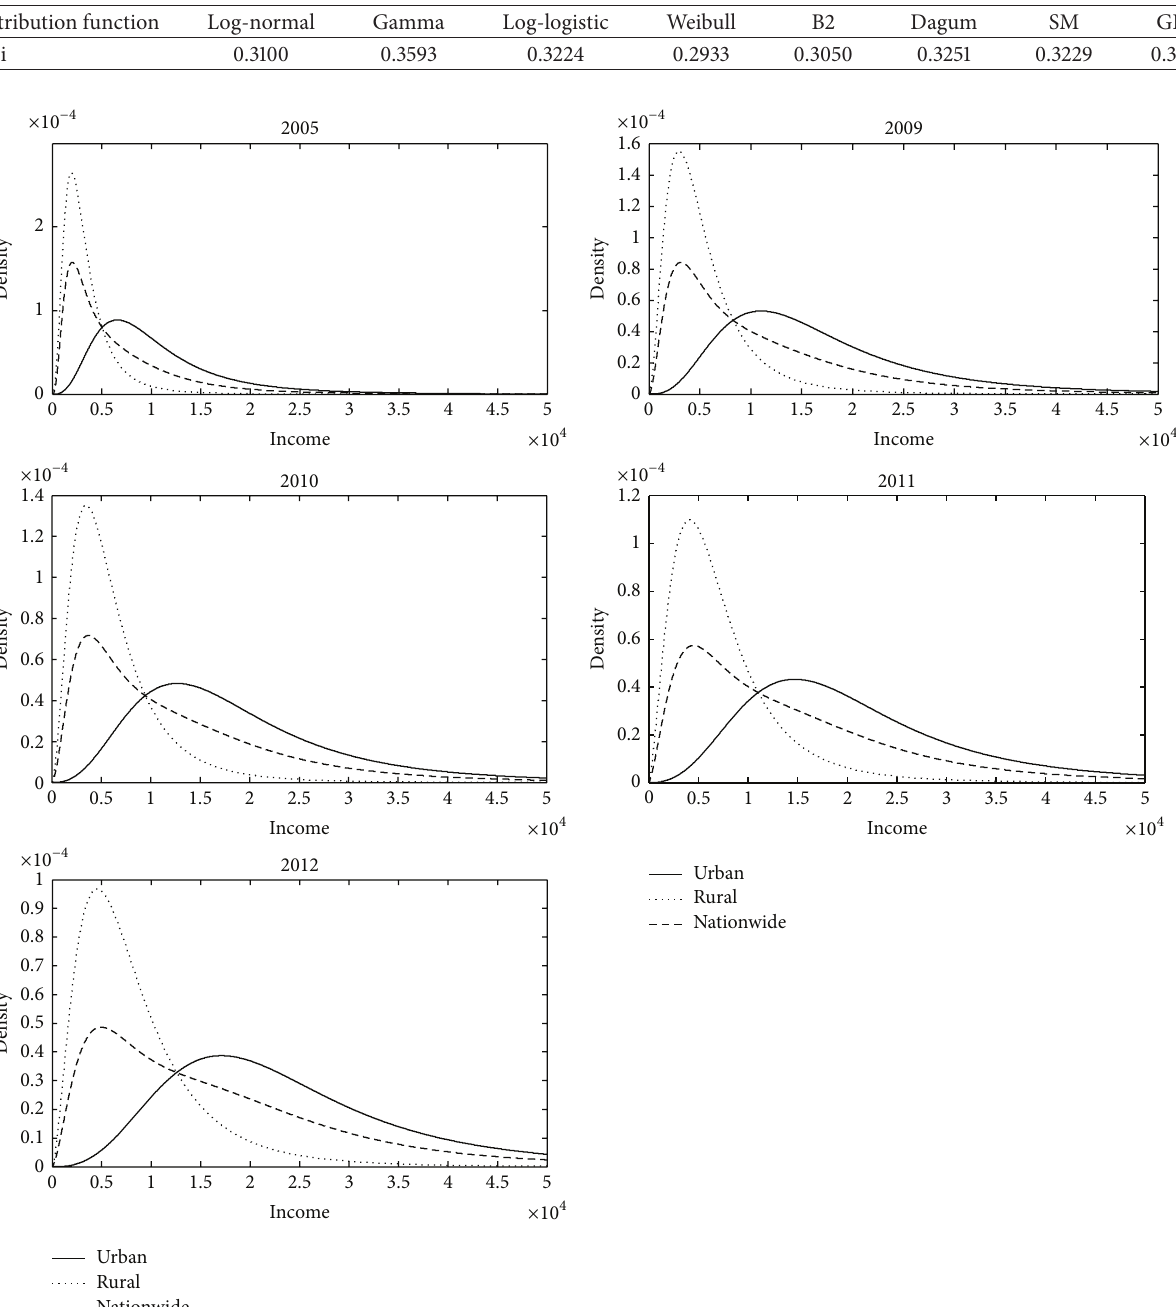
Table 2: Gini coefficient of urban residents using different distribution functions in 2012.